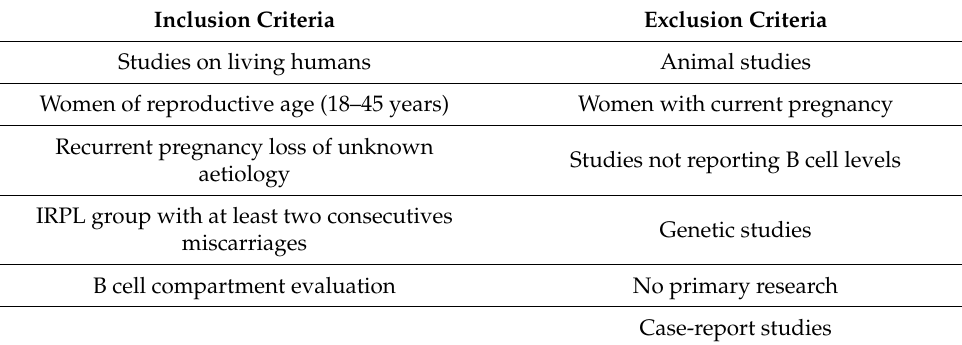
Table 1. Eligibility criteria for study